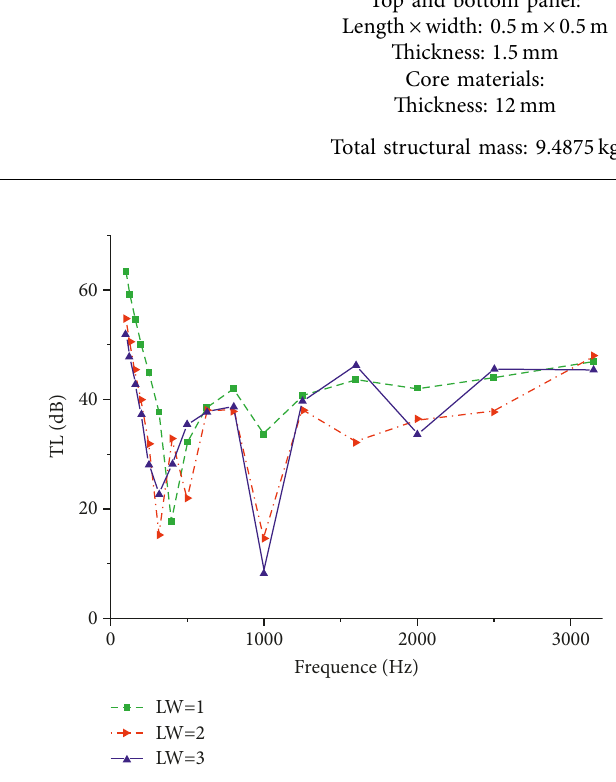
Figure 10: Influence of length-to-width ratio on sound insulation curve of SPS.